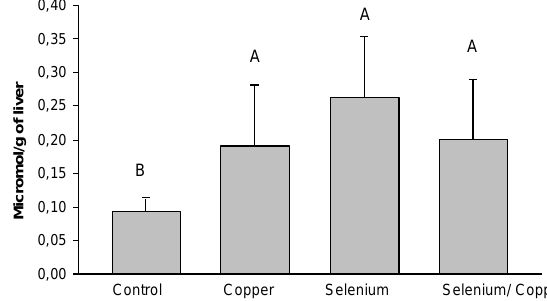
Figure 3. GSSG and standard deviations, in  mol per gram of liver, of cattle receiving control diet (without supplementation of selenium and copper), copper (40 mg/kg of DM), selenium (2 mg/kg of DM), or selenium (2 mg/kg of DM)/copper (40 mg/kg of DM).